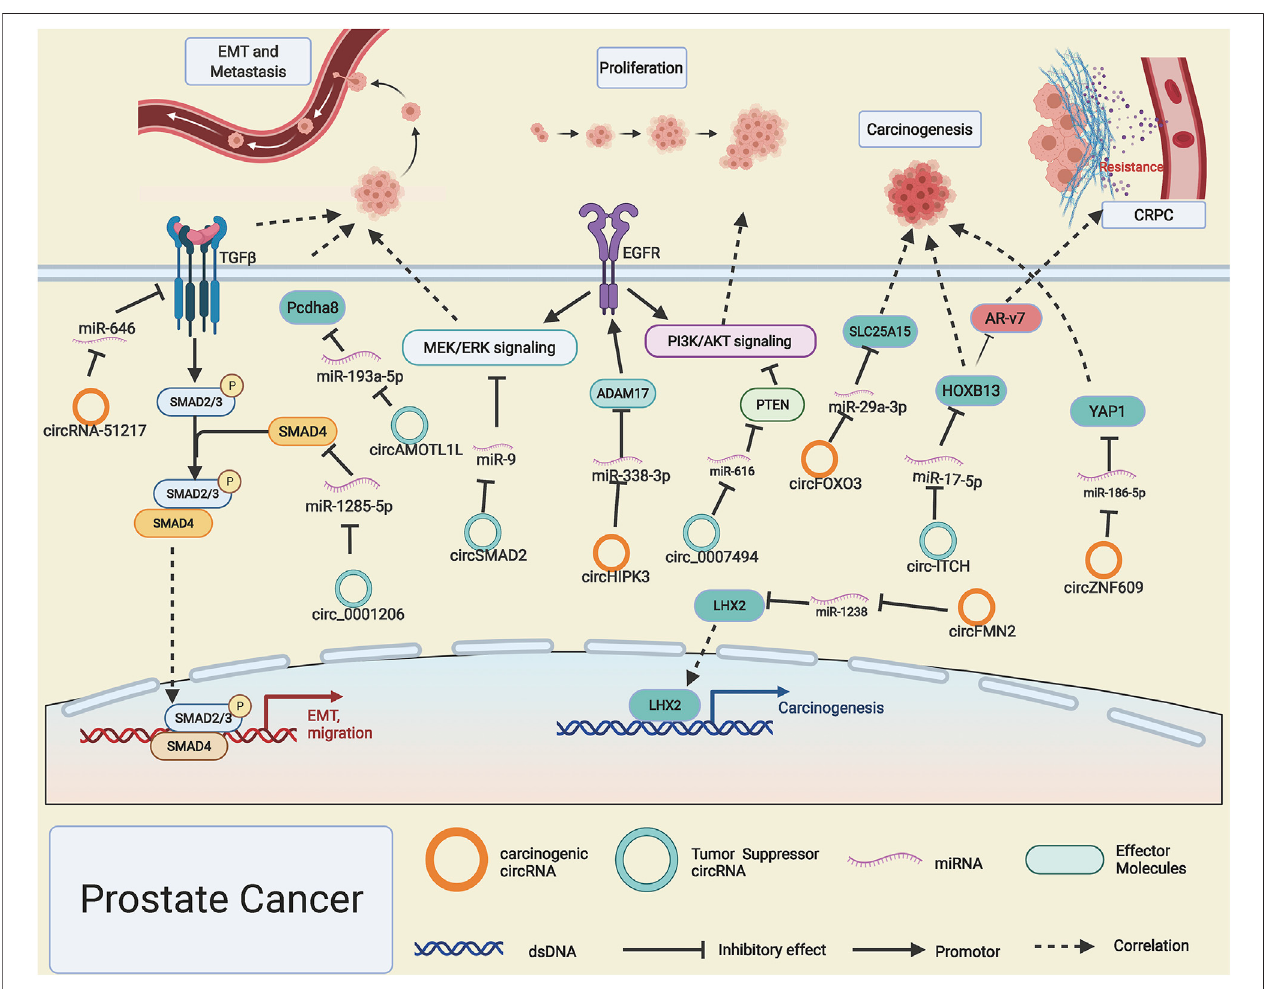
FIGURE4| Possible mechanisms ofcircRNAs inprostate cancer.UpregulatedcircRNA-51217,circZNF609, circHIPK3,circFMN2, and circFOXO3 (orange rings) and downregulated circ-ITCH, hsa_circ_0001206, circSMAD2, circAMOTL1L, and circ_0007494 (cyan rings) regulate progression of prostate cancer by altering speci fi c gene expression or tumor-related signaling